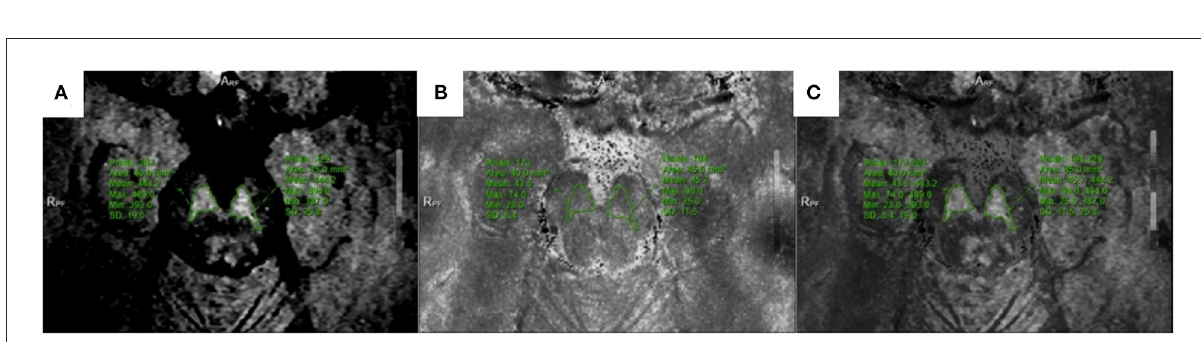
FIGURE3 Located in the lower of SNc. (A) NM-MRI map; (B) T2*mapping; (C) Combine the two maps and obtain T2*